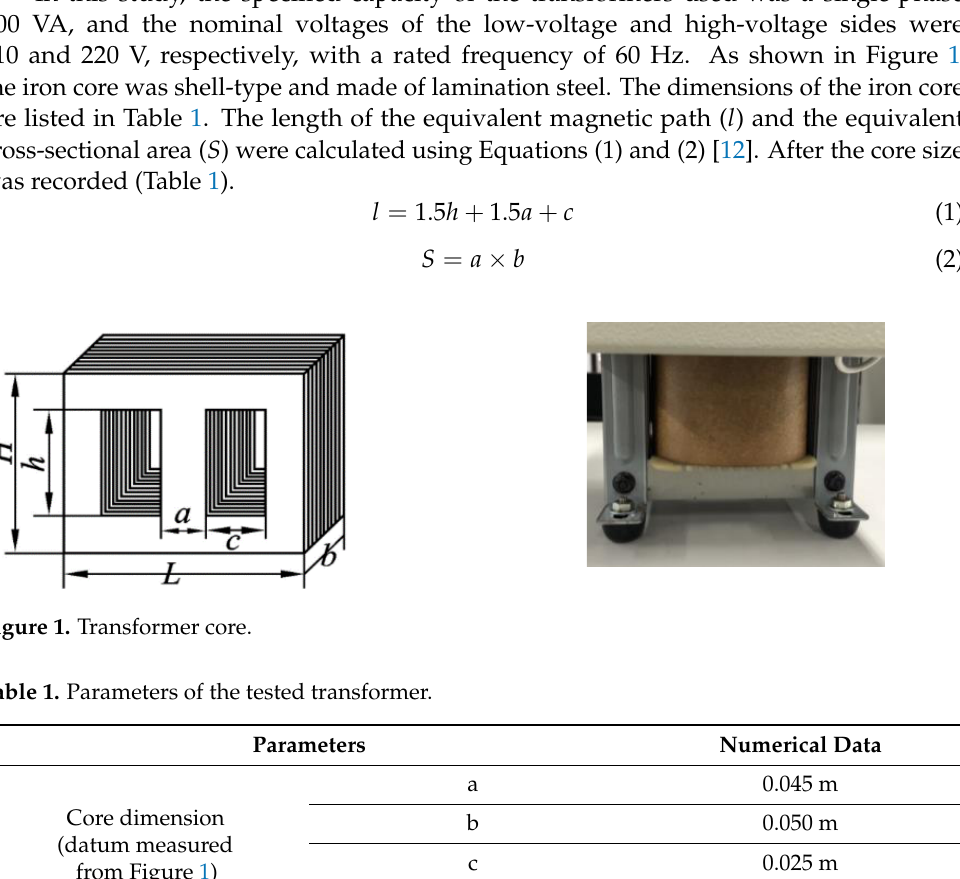
Table 1. Parameters of the tested transformer.